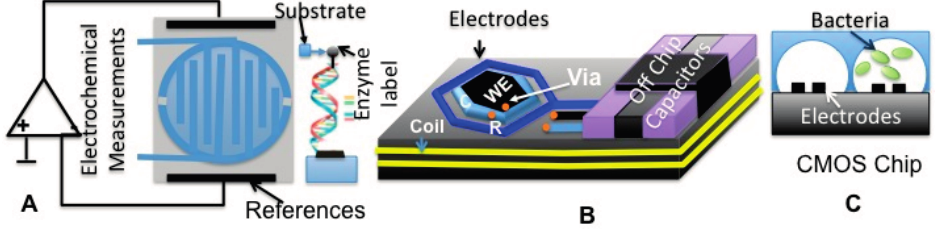
Figure 11. A CMOS biosensor: DNA detection, amperometric detection of ( A ) DNA hybridization using CMOS interdigitated microelectrodes functionalized with DNA probes; ( B ) a schematic of an implantable glucose monitoring, capacitive bacteria growth monitoring; ( C ) schematic of a differential method bacteria growth